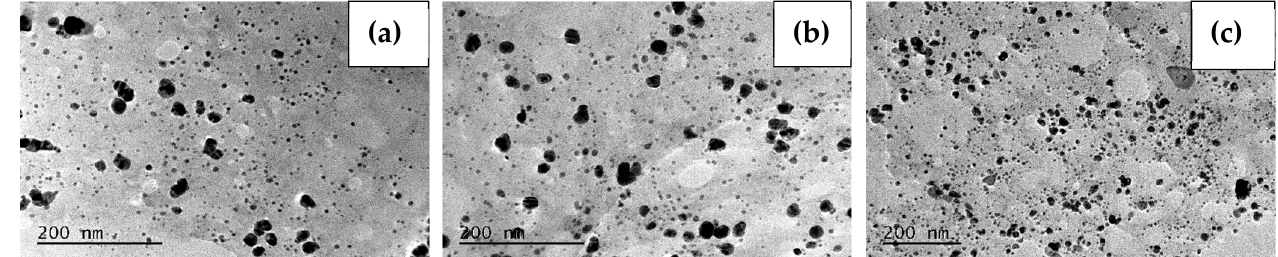
Figure 4. Size distribution for the samples ( a ) Ag-72-20 ° C, ( b ) Ag-72-30 ° C and ( c ) Ag- 72-40 ° C.